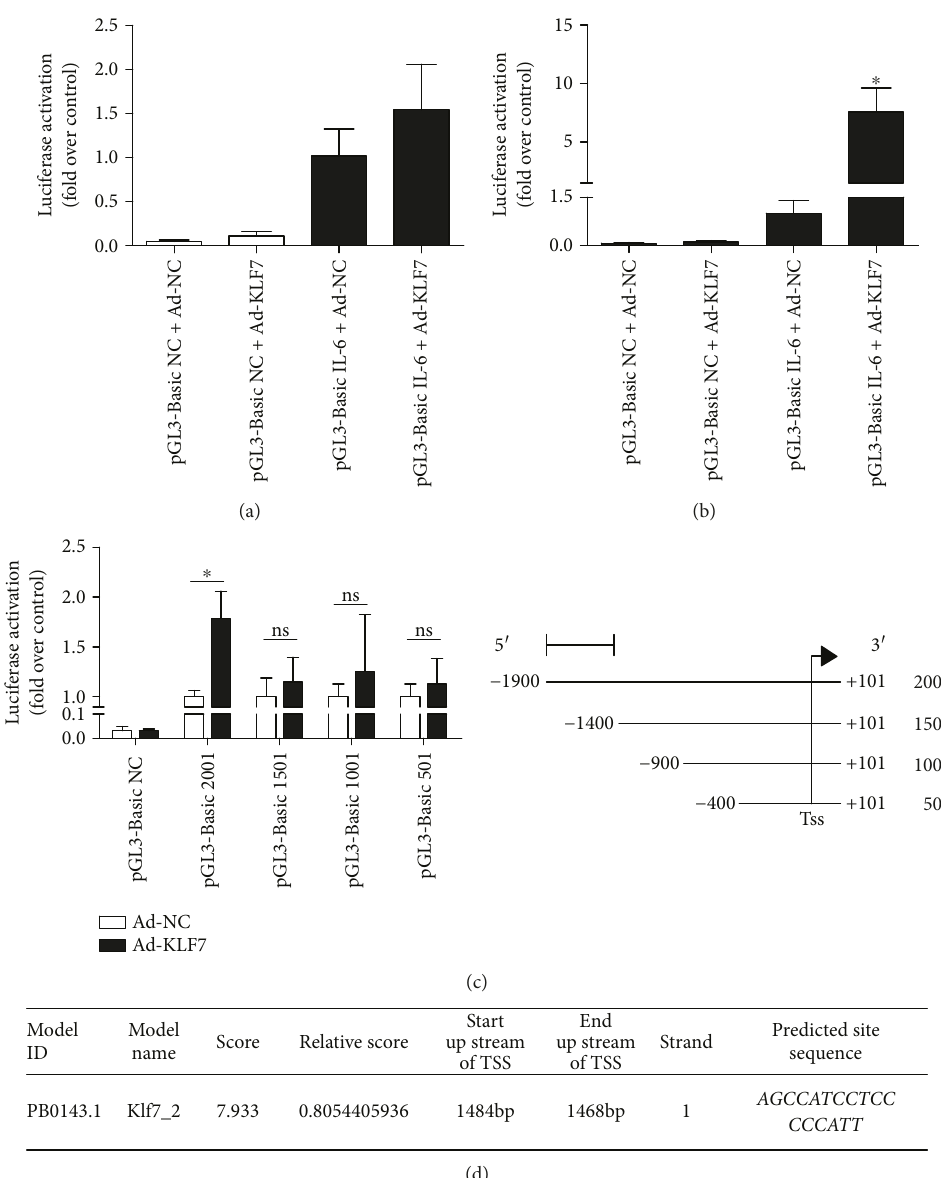
Figure 6: The transcriptional activation of IL-6 by KLF7, after the KLF7 overexpression plasmid and the IL-6 promoter luciferase plasmid were cotransfected into 293T cells: (a) 24 h and (b) 48h. Activity of KLF7 on the truncated body of the IL-6 promoter region (c). The JASPAR database software predicted that KLF7 and the IL-6 promoter region are possible binding sites (d). The data for each group is derived from three replicates of experimental data. One-way ANOVA (a, c), Kruskal-Wallis H test (b), Ad-NC 2001: Ad-KLF7 2001, ∗ P < 0 05 ; ns: no signi fi cant di ff erence; the di ff erence was statistically signi fi